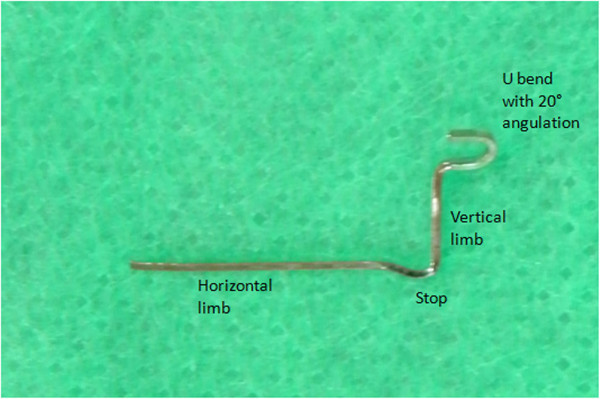
Parts of the stent.